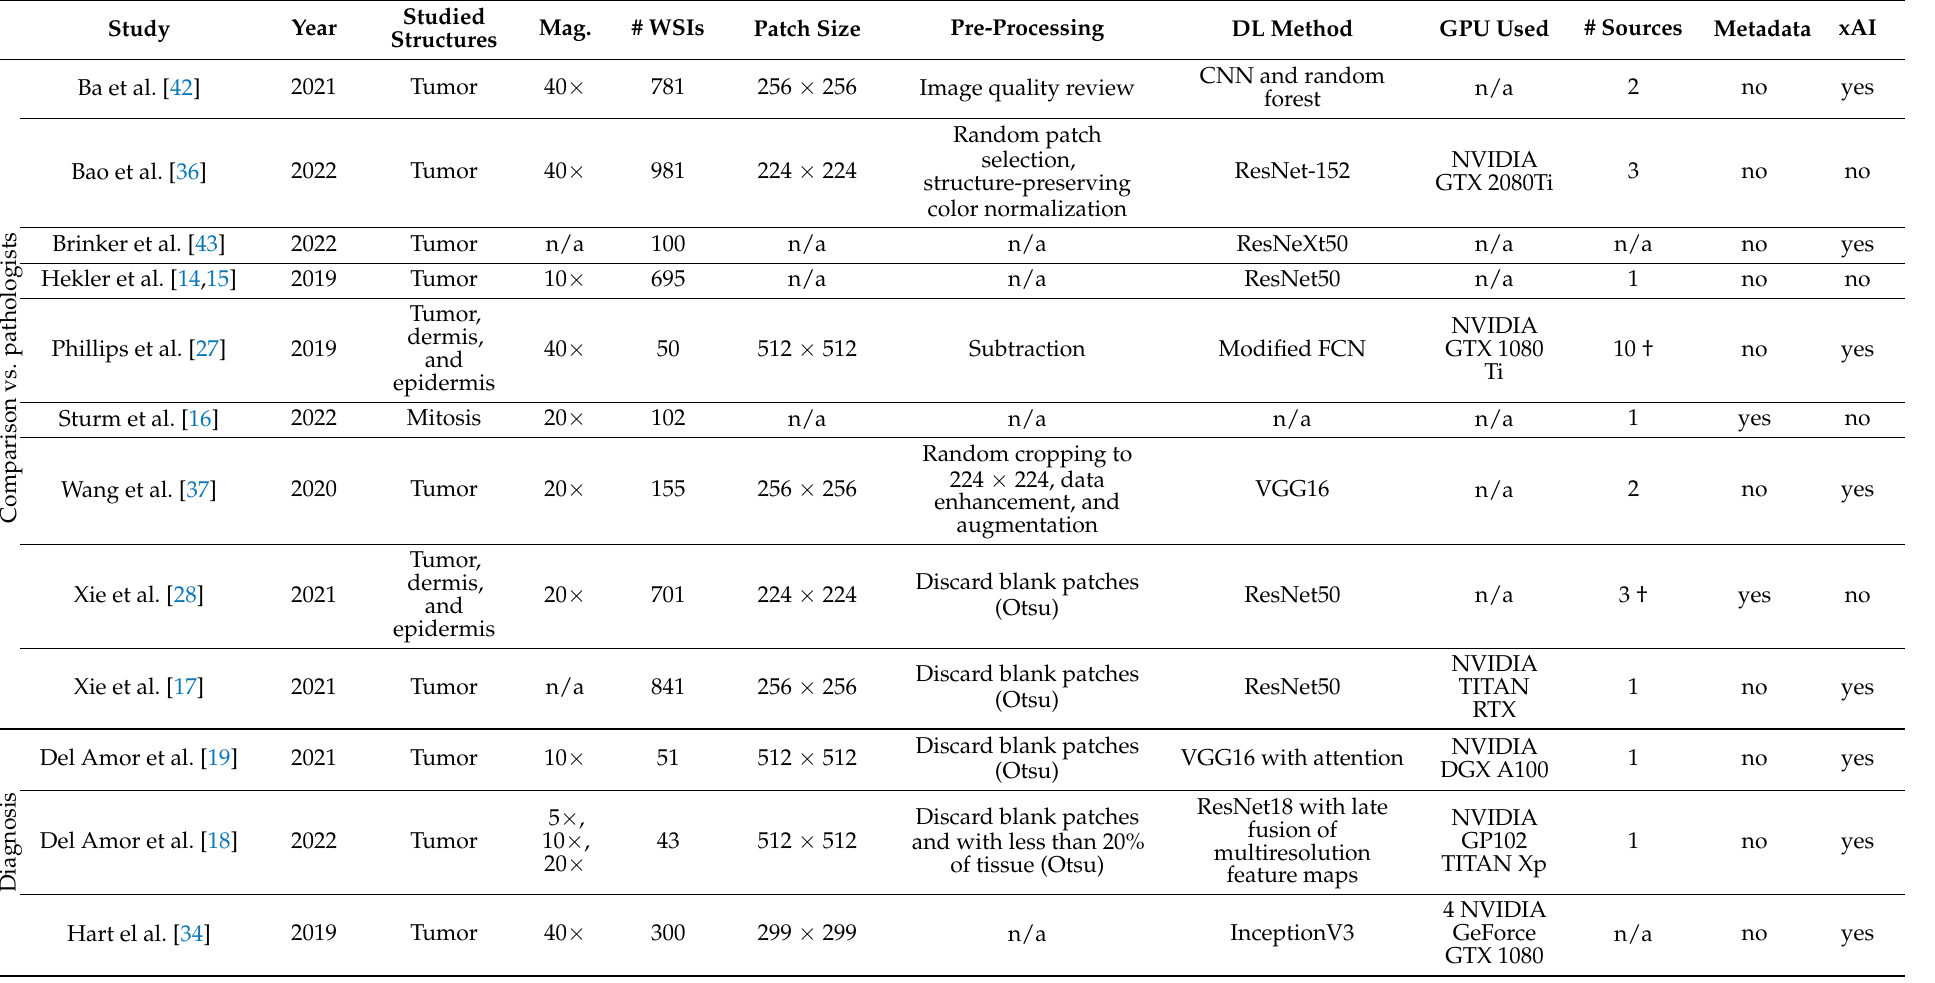
Table 1. Studiesincluded in the systematic review, divided into the four previously defined categories, along with their main parameters. Mag.: magnification level. n/a: not available. #: Number. xAI: studies that provide elements for explainable AI, e.g., GradCAMs or attention